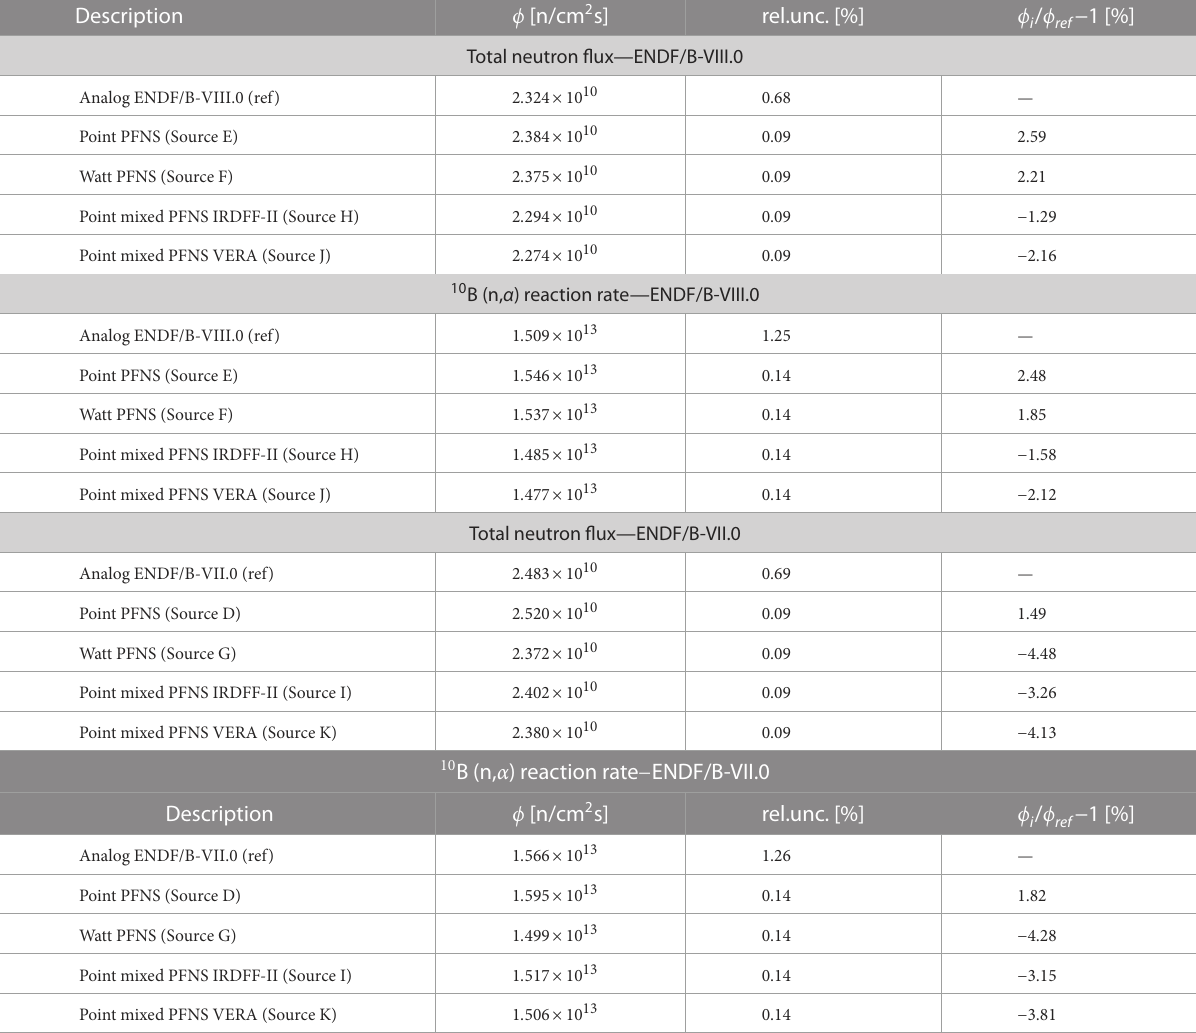
TABLE3 00Calculatedtotalneutronfluxand 10 B(n, α )reactionrateatex-corepowerrangedetectorlocationfordifferentpromptfissionneutronsource (PFNS)descriptionsusingENDF/B-VIII.0andENDF/B-VII.0nucleardatalibrary.Resultsarenormalizedtonominarreactorpowerof2 GW.